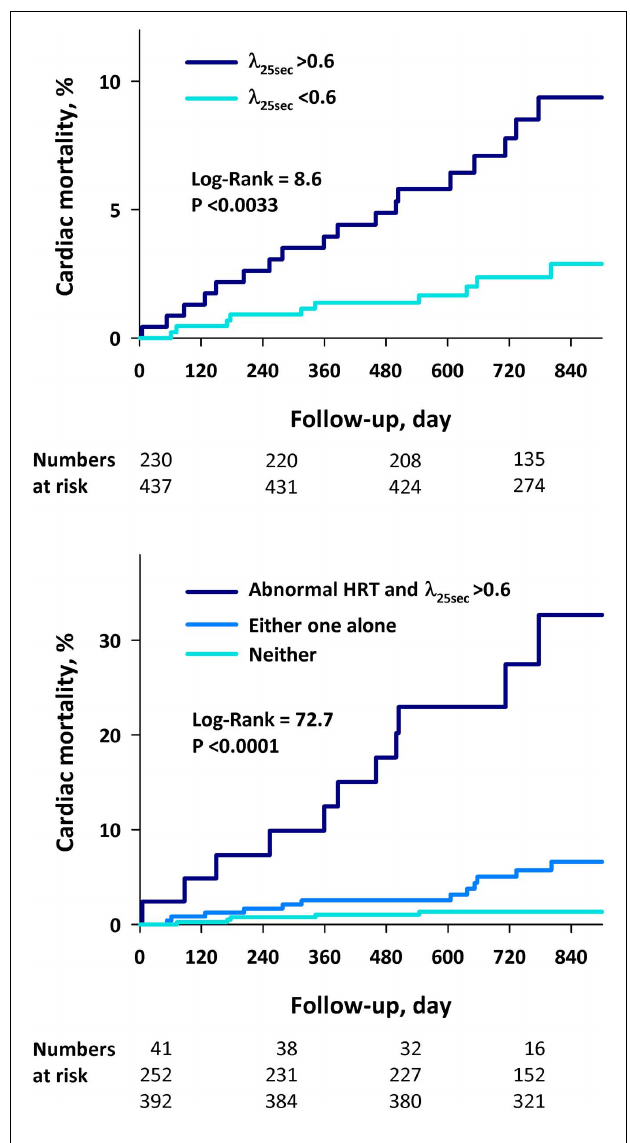
FIGURE 4 | Kaplan–Meier curves for cardiac death afterAMI. The patients were stratified by λ 25s > 0.6 and by the combination of λ 25s > 0.6 and abnormal